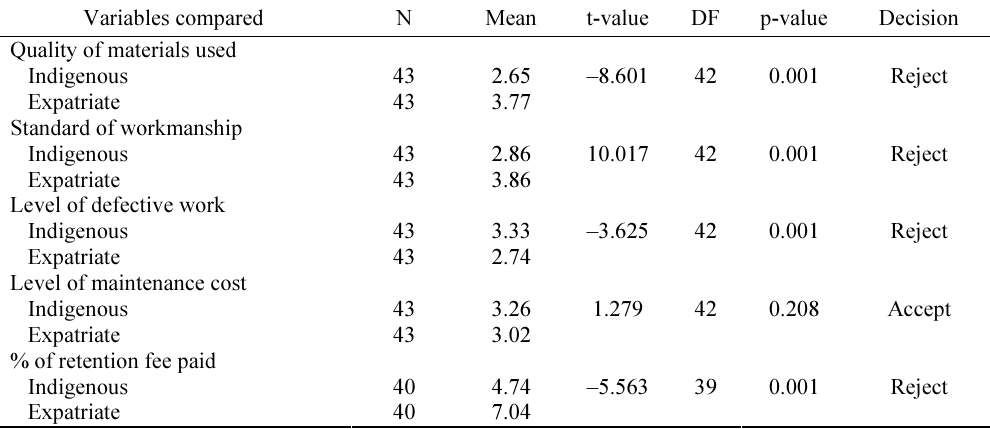
Table 5. Results of t-test for difference in quality performance between indigenous and expatriate contractors Variables